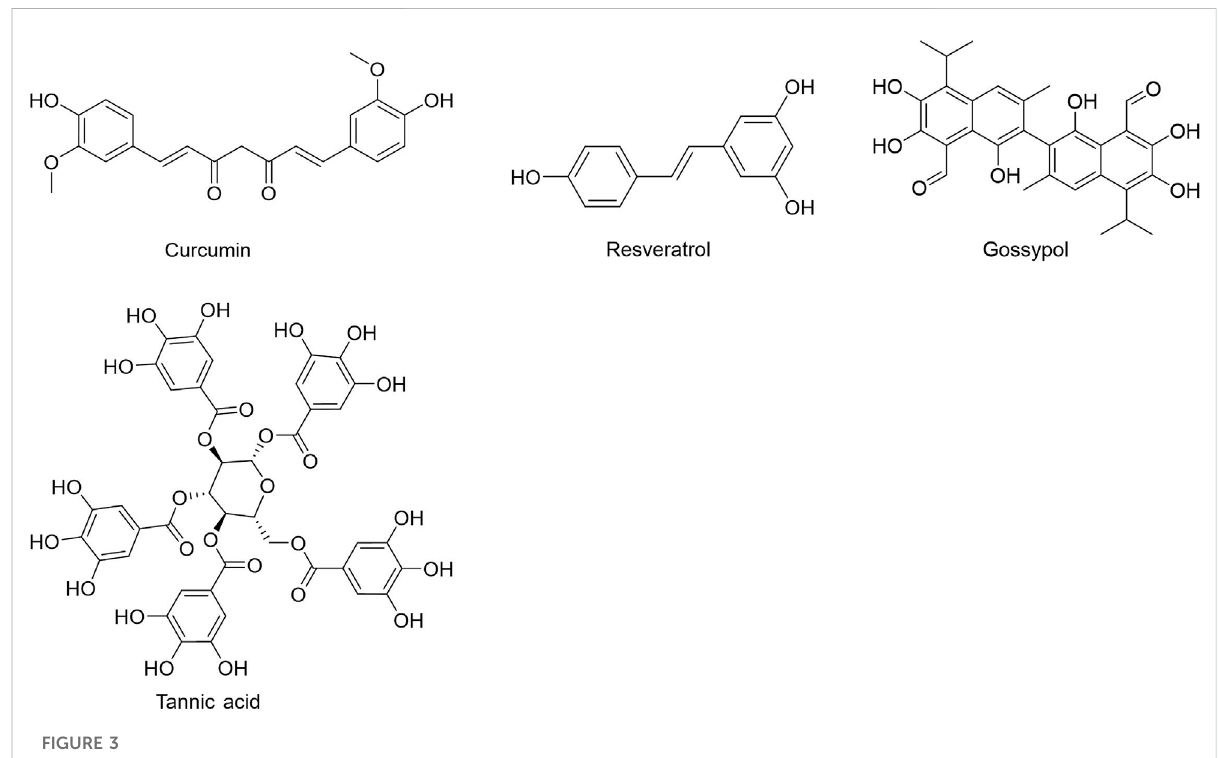
FIGURE 3 Non- fl avonoid phenolic